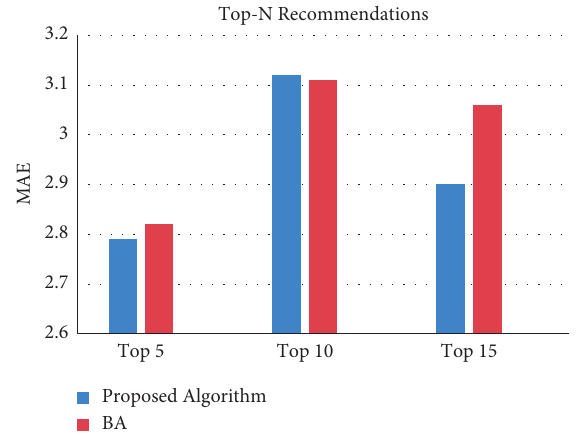
Figure 5: MAE for the two recommender systems for dataset